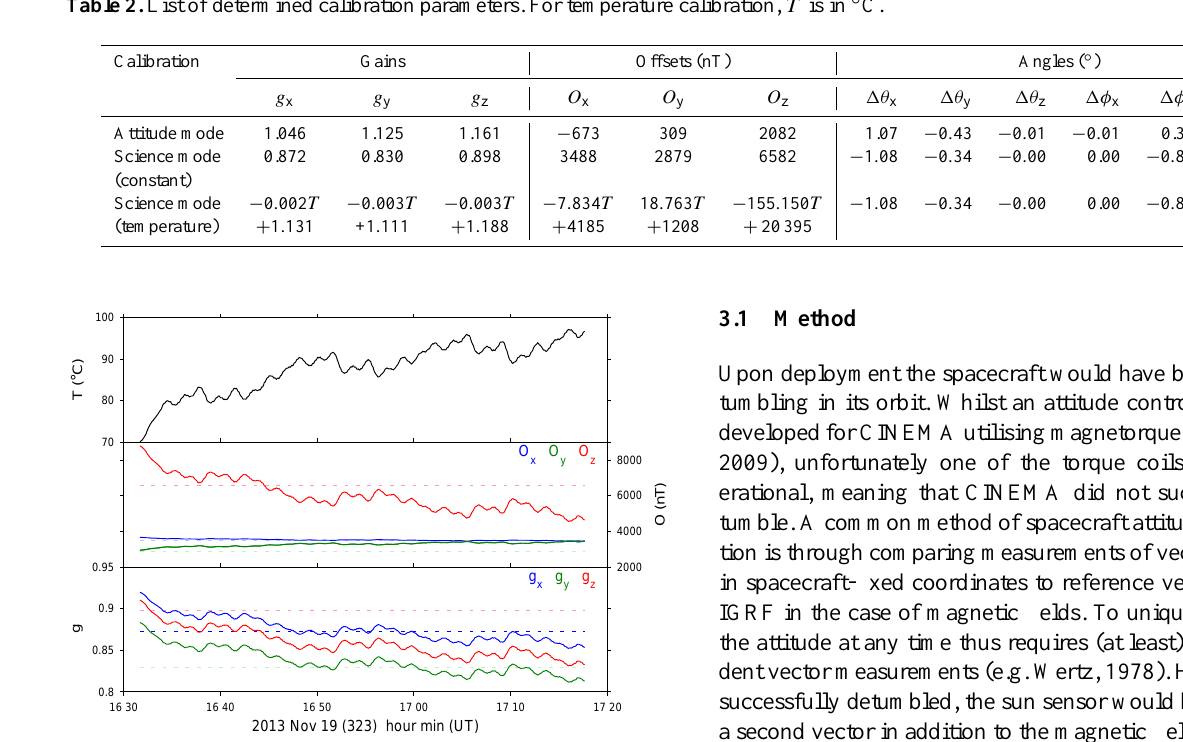
Figure 4. From top to bottom: temperature at the outboard sensors; determined temperature-dependent offsets and gains (x, y, z in blue, green, red), where the dotted lines indicate the previous constant calibration